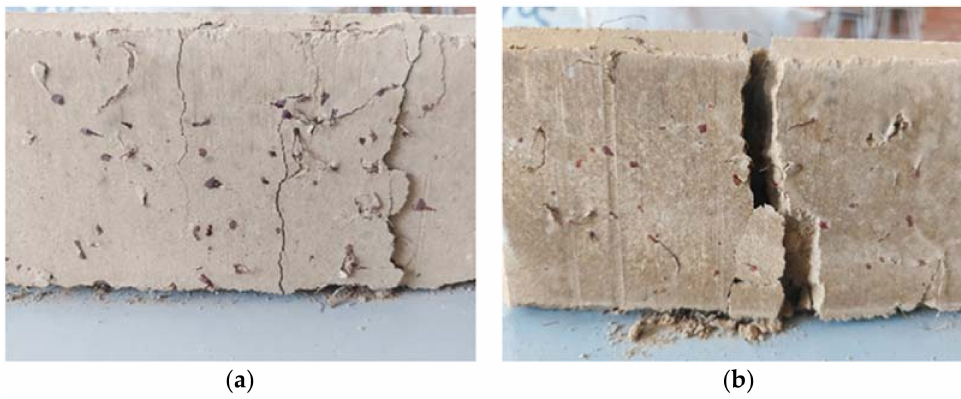
Figure 9. Tested soil–cement WTSF blocks: ( a ) 0.75% WTSF and ( b ) 1.50% WTSF. In order to verify whether the compression strength average values by age are statis- tically significantly different, an analysis of variance (ANOVA) (Table 4) was performed, considering a significance value of 0.01. Table 4. ANOVA analysis for concrete strength delimited by aging.